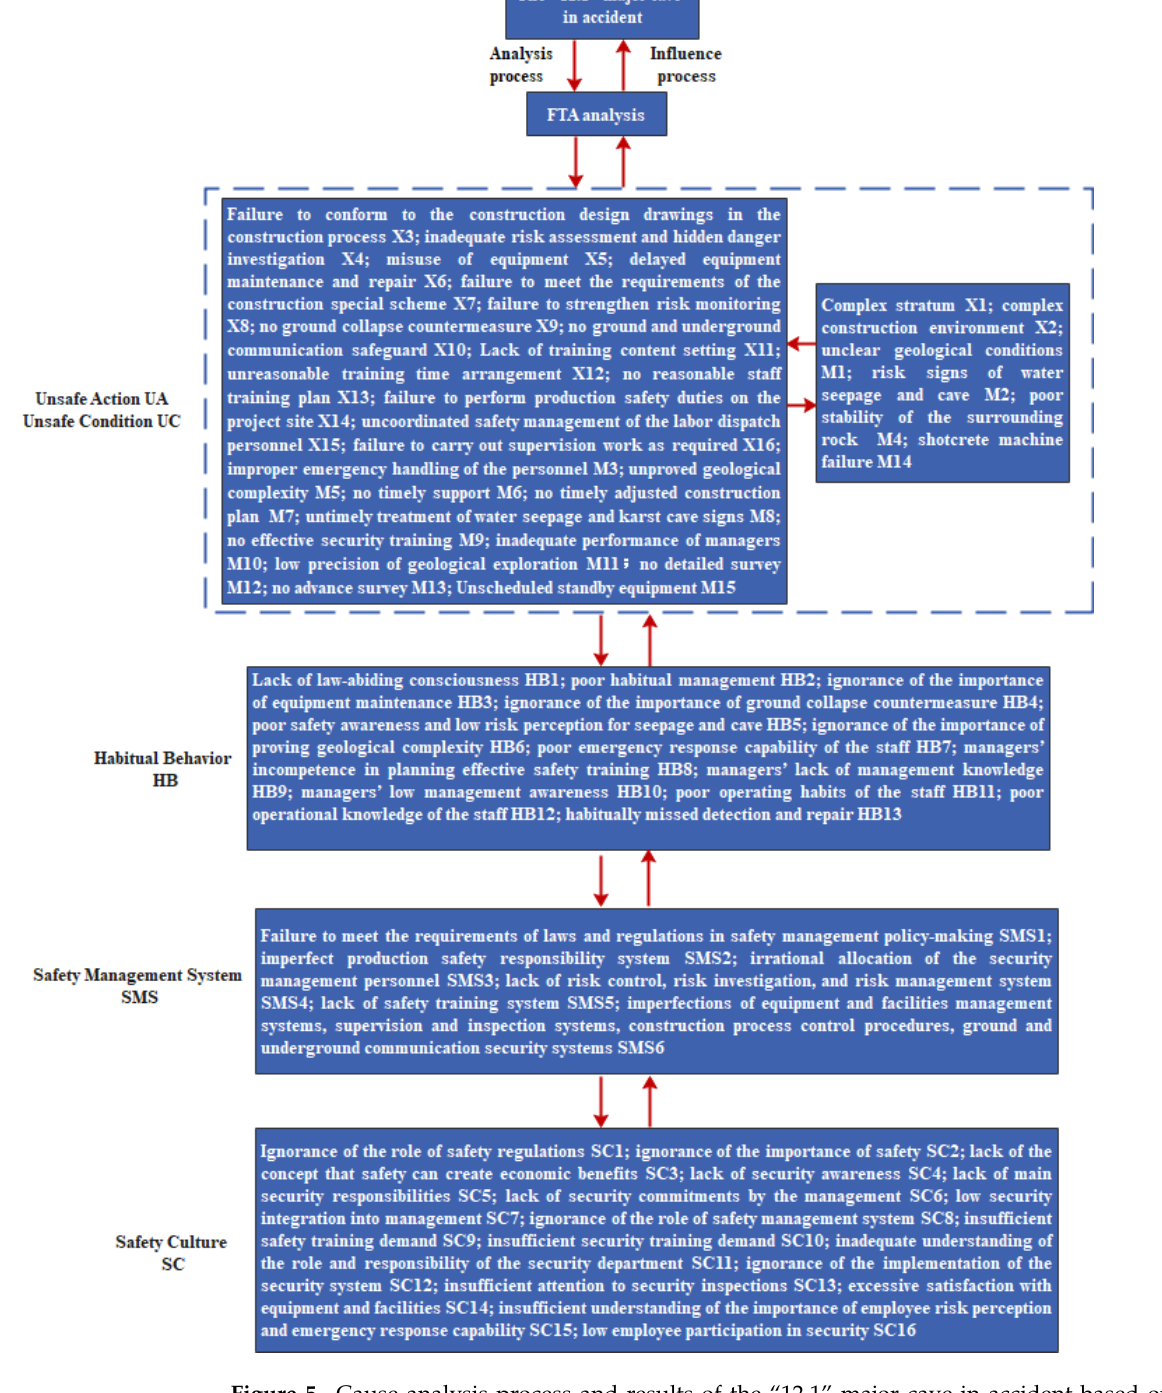
Figure 5. Cause analysis process and results of the “12.1” major cave-in accident based on the FTA ‐ 24Model.